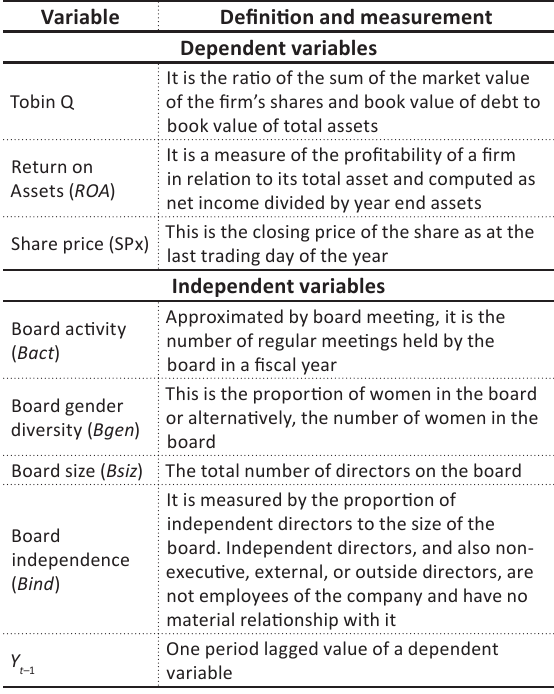
Table 1. Variable definition and